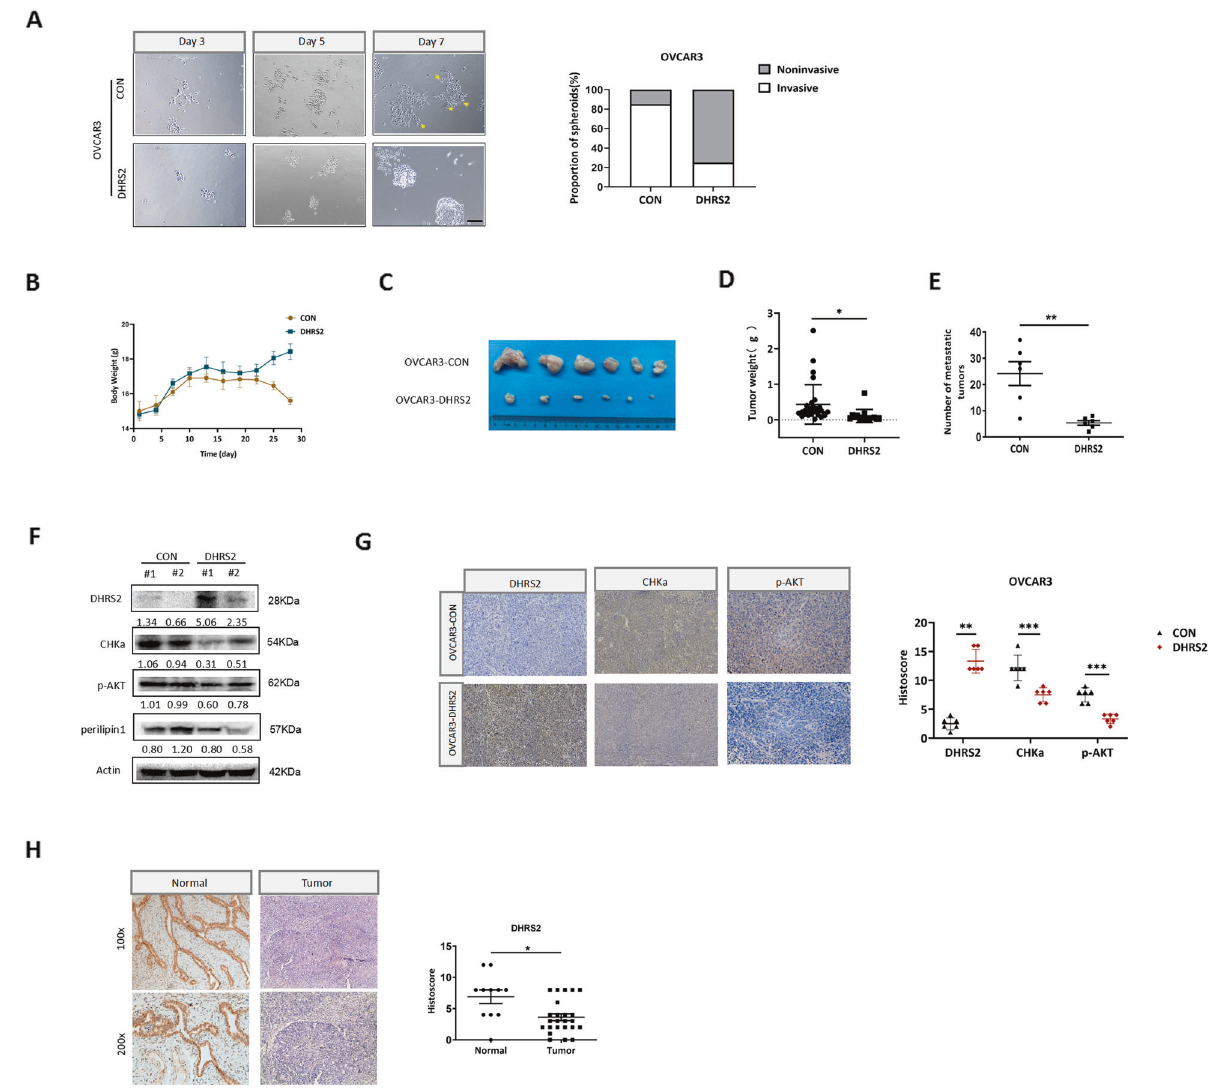
Fig. 6 DHRS2 hampers the invasion and metastasis of OC cells. A Representative images of spheroids formed by OVCAR3 cells in Matrigel (left). The invasive spheroids were featured by scattered protrusions formed on the spheroid surface, as indicated by yellow arrows. Scale bar, 50 μ m. Proportion of two spheroid types in OVCAR3-CON and OVCAR3-DHRS2 cells (right) ( p < 0.05). Stable OVCAR3-CON and OVCAR3-DHRS2 cells were injected into the abdominal cavity, respectively ( n = 6 per group). B During the experiment, the body weight of the mice was determined every 3 days and shown in the graph. C Representative intraperitoneal metastatic tumors in the designated group. D , E The amount and mass of the metastatic tumors were shown in the graph. F The protein levels of DHRS2, CHK α , p-AKT, and perilipin1 in tumor tissues of the designated group. G Representative images of tumor sections in each group stained with indicated antibodies. H The representative images of DHRS2 staining in OC tissues and non-tumor tissues. The scatter diagram shows Histoscore for DHRS2 staining in the designated samples. Data are shown as mean values ± S.D. of independent, triplicate experiments. The asterisks (*,**,***) indicate signi fi cant differences ( p < 0.05, p < 0.01, p < 0.001, respectively). the OVCAR3-DHRS2 group relative to those in the OVCAR3-CON used to simulate the extracellular microenvironment and ree- group (Fig. 6F). Similar observations were acquired by H&E and merge the process of cell adhesion and invasion. Invasive IHC staining (Fig. 6G, Supplementary Fig. 5). These fi ndings spheroids with scattered protrusions were observed in OVCAR3- indicate that DHRS2 hampers the invasion and metastasis of OC CON cells, whereas OVCAR3-DHRS2 cells displayed relatively through the inhibition of CHK α -AKT axis and choline metabolism. smooth edges with fewer protrusions (Fig. 6A). In order to explore Moreover, we examined DHRS2 protein expression in 24 cases the role of DHRS2 in tumor metastasis in vivo, we established an of OC tissues and 11 cases of normal specimens, and signi fi cantly intraperitoneal metastatic animal model. Stable OVCAR3-CON and reduced DHRS2 expression was observed in OC tissues relative to OVCAR3-DHRS2 cells were injected into the abdominal cavity, normal controls (Fig. 6H). Pearson correlation analysis revealed respectively ( n = 6 for each group). Our results showed that both that DHRS2 expression was inversely correlated with the distal the amount and mass of abdominal-metastatic tumors were metastasis of OC ( p < 0.05, Supplementary Table 1). This further remarkably decreased in the OVCAR3-DHRS2 group (Fig. 6B – E). supports the idea that DHRS2 downregulation contributes to the DHRS2 protein expression was upregulated, whereas CHK α , p-AKT, metastatic progression in OC patients. and perilipin1 expression levels were substantially decreased in